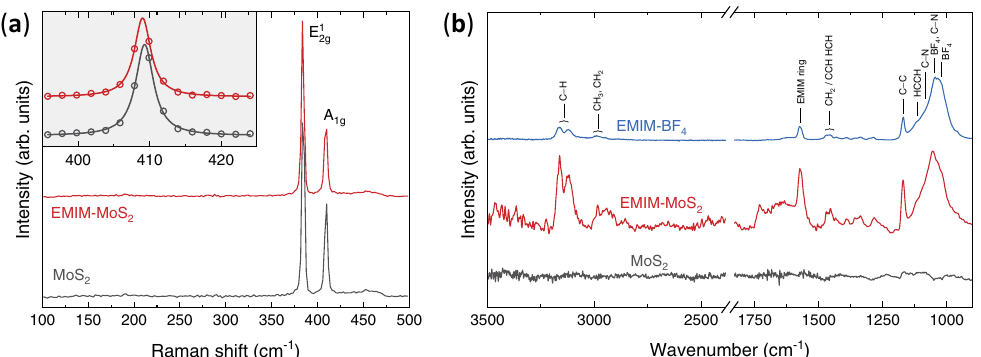
Figure 2. Vibrational spectroscopies of pristine and intercalated MoS 2 . ( a ) Raman spectroscopy at 514 nm in the spectral range between 100 and 500 cm − 1 , showing the E 1 2g mode at ∼ 384 cm − 1 and the A 1g mode at ∼ 409 cm − 1 . Inset shows a magnification of the data in the A 1g region close to 409 cm − 1 . Solid lines are Lorentzian fits. ( b ) FT-IR absorption spectra acquired in ATR mode between 3500 and 900 cm − 1 . Peak assignments for the spectrum of EMIM-BF 4 are